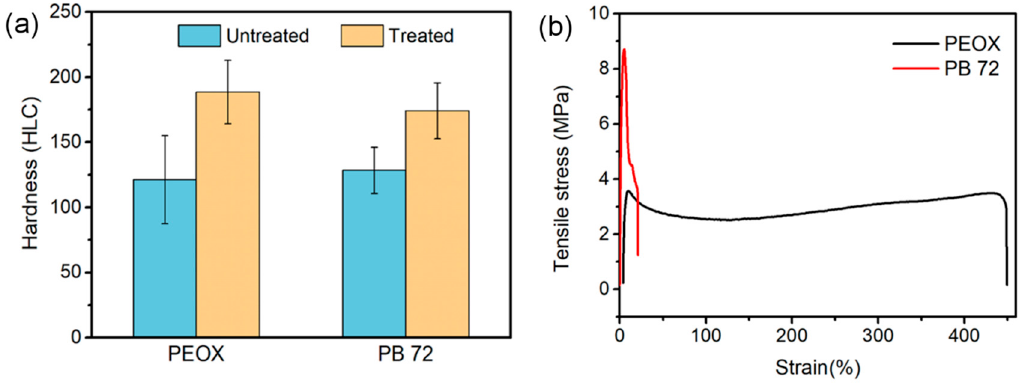
Figure 4. ( a ) The hardness values of the untreated area and treated area; ( b ) Tensile stress-strain curves of PEOX and PB 72 (curves that are mostly close to the average values are selected to represent each consolidant).